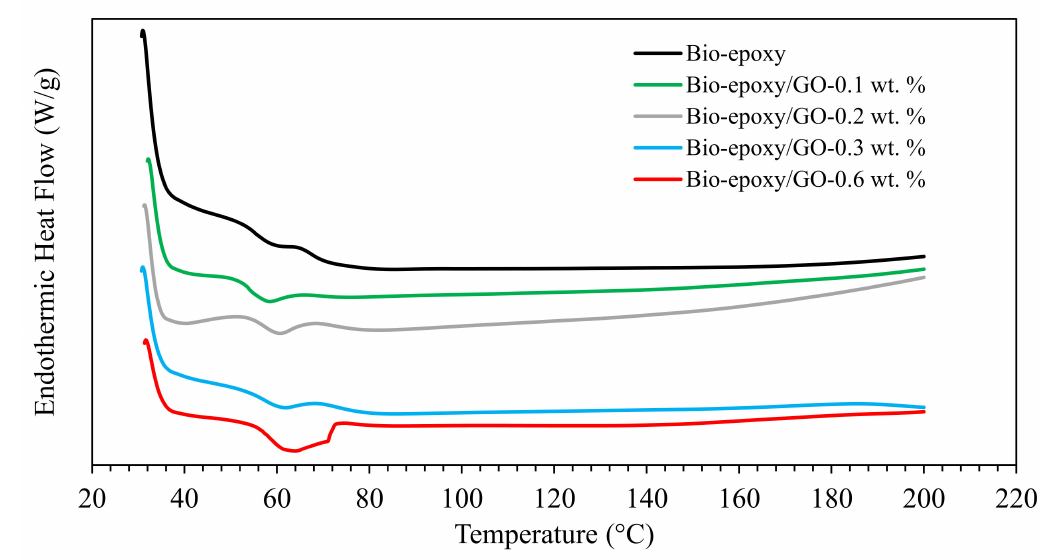
Figure 11. Differential scanning calorimetry (DSC) thermographs of pure bio-epoxy and bio-epoxy/0.1–0.6 wt.% GO composites (endo ↓